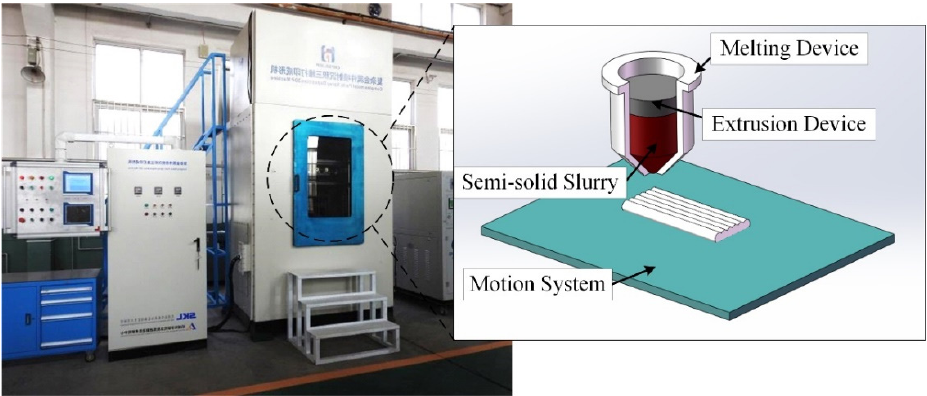
Figure 2. Semi-solid direct-writing forming equipment diagram. Table 2. Process test parameters.